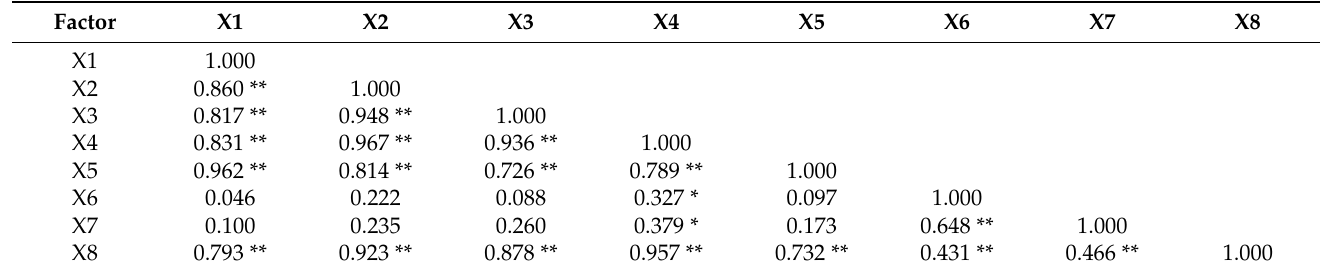
Table 3. Correlation coefficient matrix of the driving factors (2010–2019).